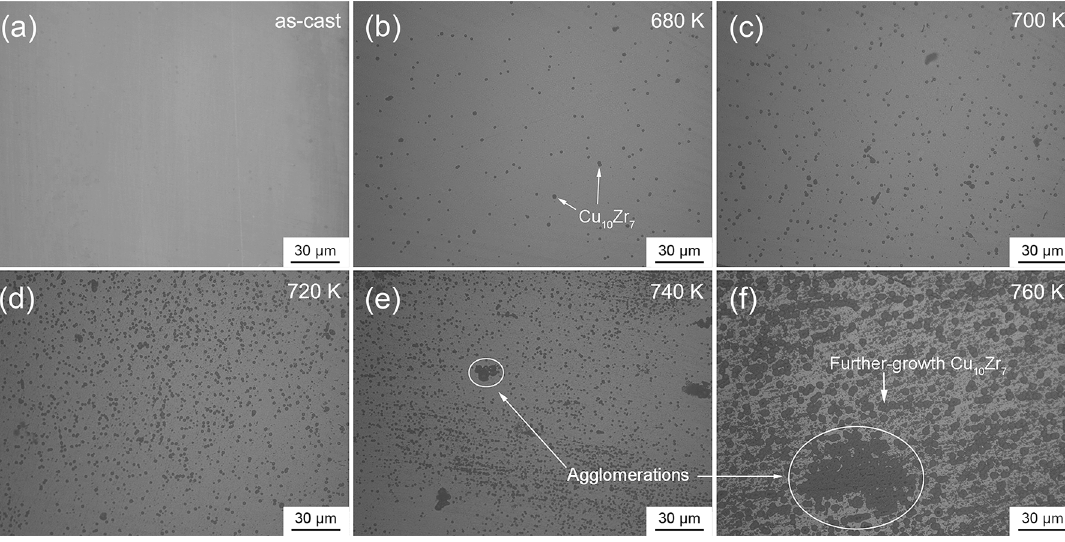
Zr Al ) Y Nb alloys annealed at different temperatures for 30 min: (a) as-cast; (b) 680 K; (c) 700 47 45 8 97.5 1.5